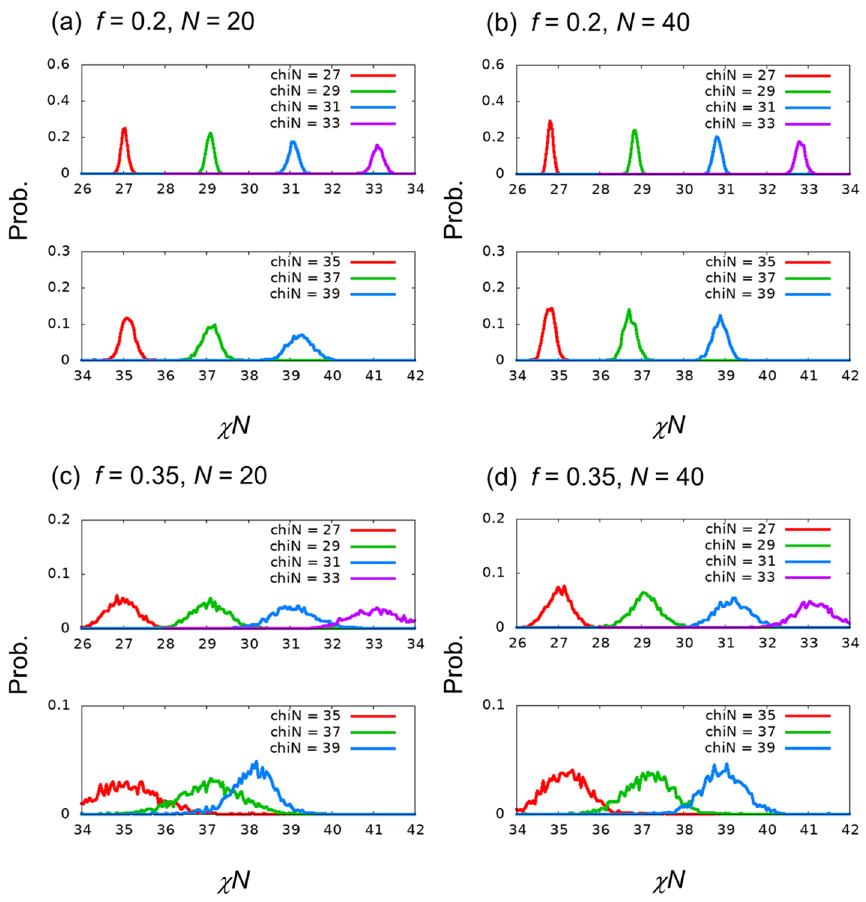
Figure 5. Probability distribution functions of the estimated χ N for evaluation data generated with unlearned χ N values.